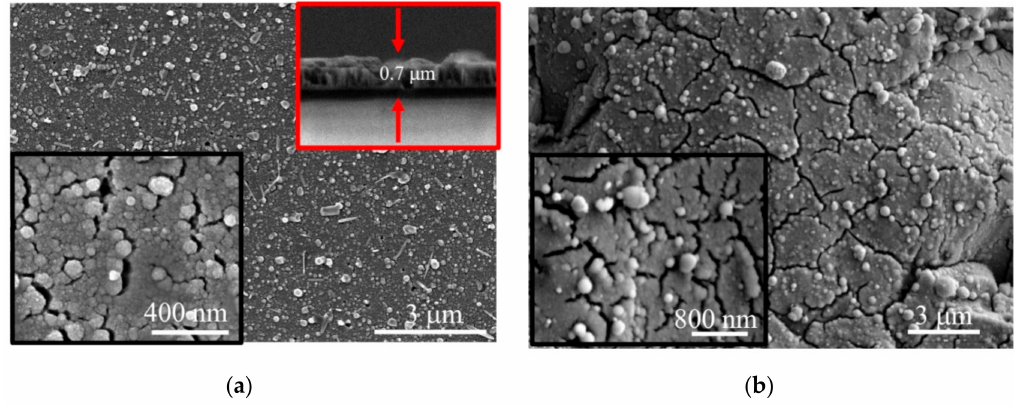
Figure 9. SEM images (two magnifications) of MoS x ~3 + δ films obtained on ( a ) Si / SiO 2 and ( b ) glassy carbon substrates by o ff -axis PLD in Ar at a pressure of 8 Pa for 20 min. The top inset in ( a ) shows a cross-sectional image of the